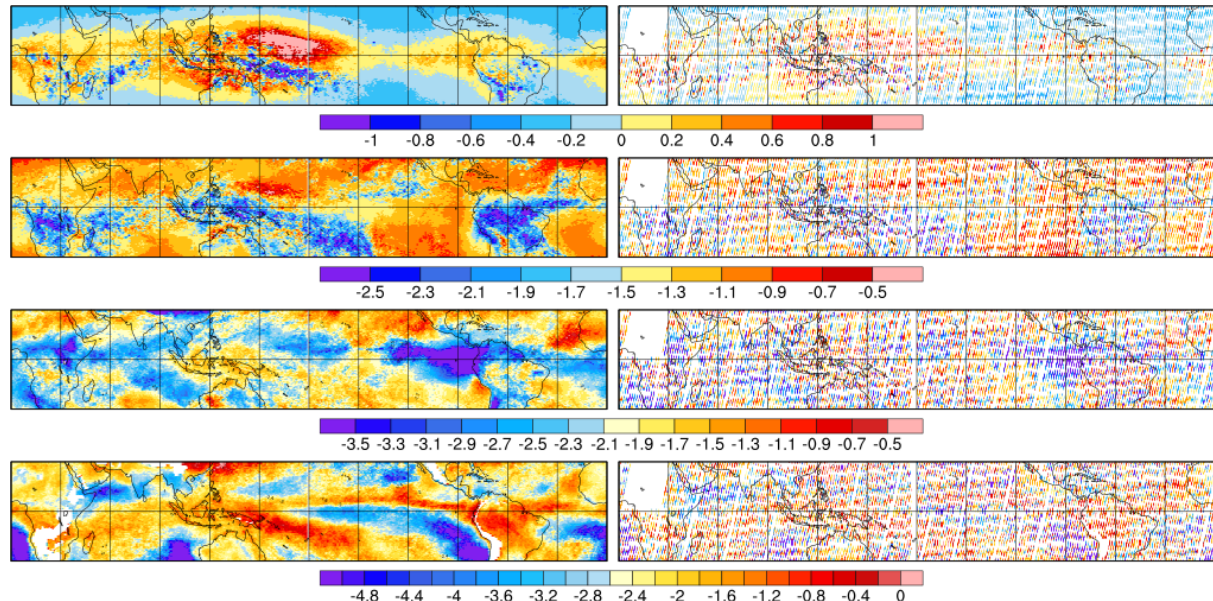
Figure 4. Geographical maps of LW heating rates (K per day) in four layers: 106–131, 200–223, 525–585 and 850–900hPa (from top to bottom) averaged over January 2008 at 01:30LT. Left: predicted over the AIRS swath, using the combination of the eight models developed for Cb, Ci/thin Ci, mid- and low-level clouds and clear sky, separately over ocean and over land. Right: from NASA FLXHR data along the CALIPSO–CloudSat nadir tracks.